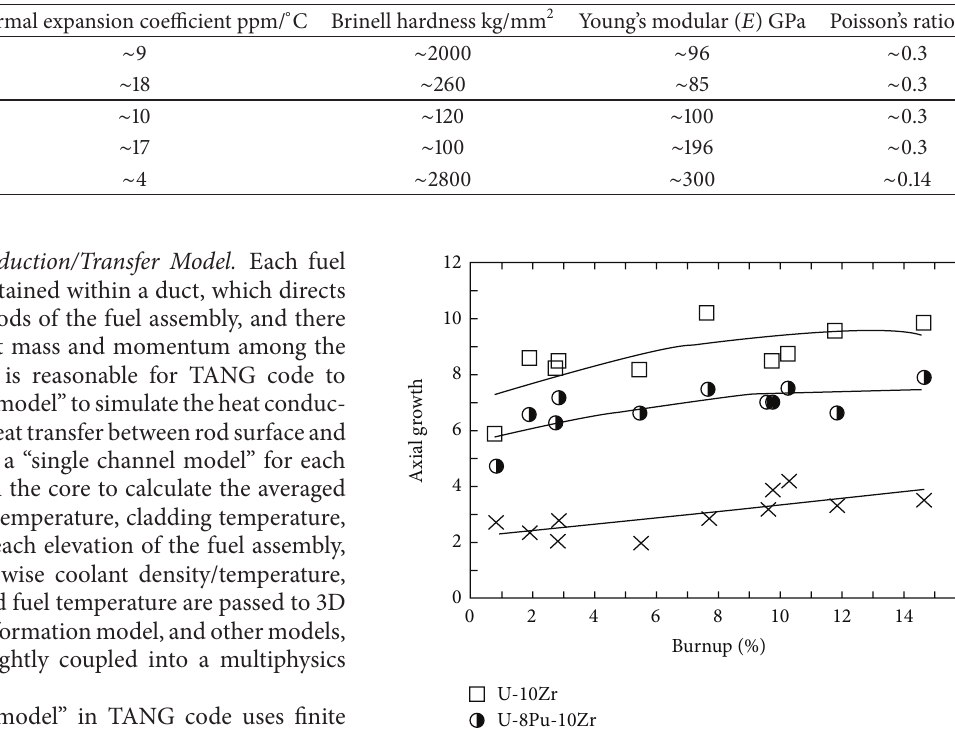
Table 2: Properties of several typical fuel materials.